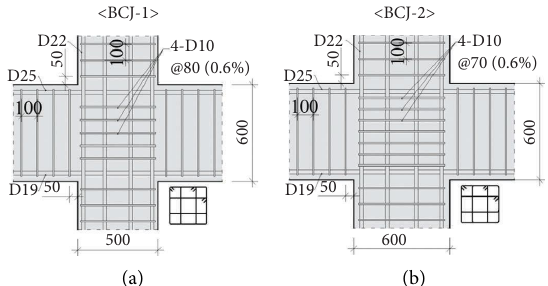
Figure 5: Details of joint shear reinforcements (units in mm). (a) Interior joints in frame PF4. (b) Interior joints in frame